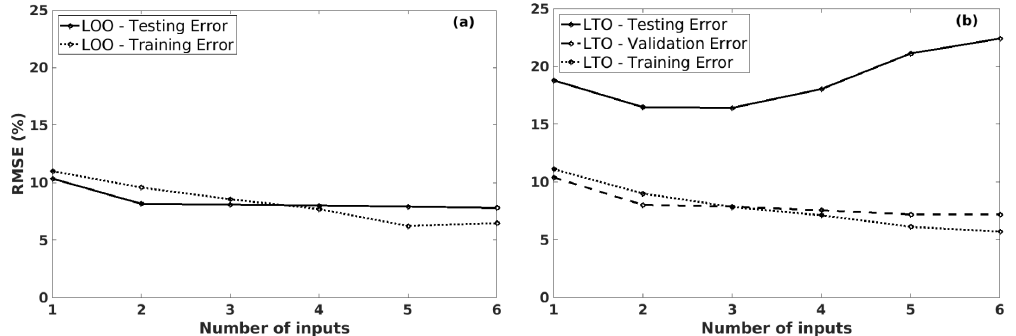
Figure 5. The training, validation, and/or testing RMSE values of the predicted coffee yield anomalies, using different LIN models (with 18 potential predictors) by increasing the number of inputs, in Cu M’gar (Dak Lak, Vietnam): (a) is induced from the LOO procedure, and (b) is from the LTO procedure.